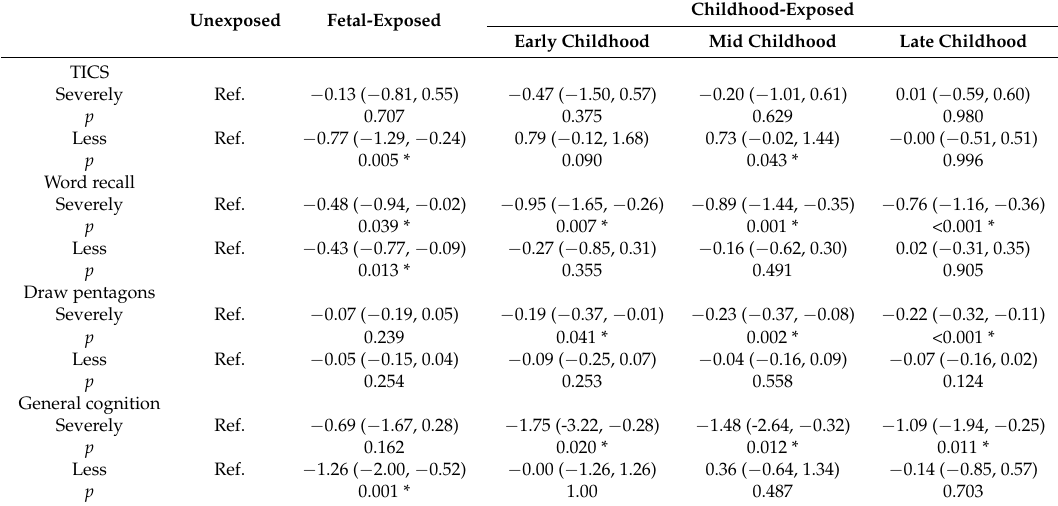
Table 4. Association between famine exposure and cognitive decline stratified by famine severity. Unexposed